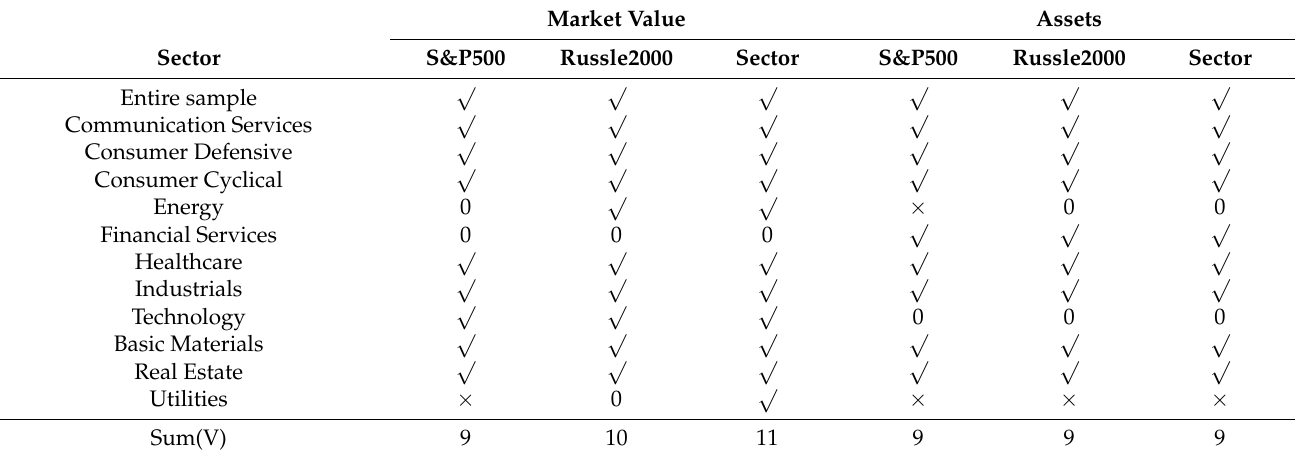
Table 4. CAAR Results by Sector.